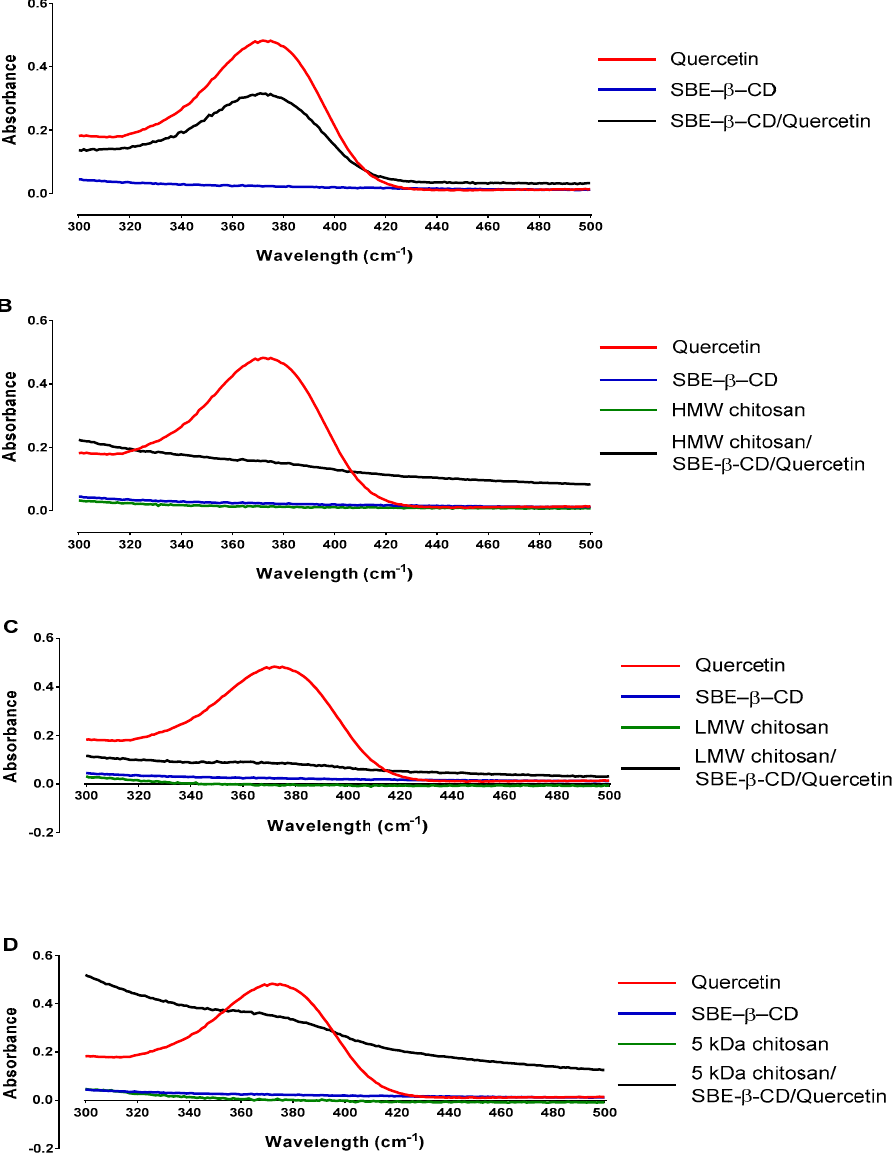
Figure 1. UV/visible absorbance spectrum of ( A ) SBE– β –CD/quercetin inclusion complexes; ( B ) HMW chitosan/SBE– β –CD/quercetin delivery systems; ( C ) LMW chitosan/SBE– β –CD/quercetin delivery systems and ( D ) 5 kDa chitosan/SBE– β –CD/quercetin delivery systems.